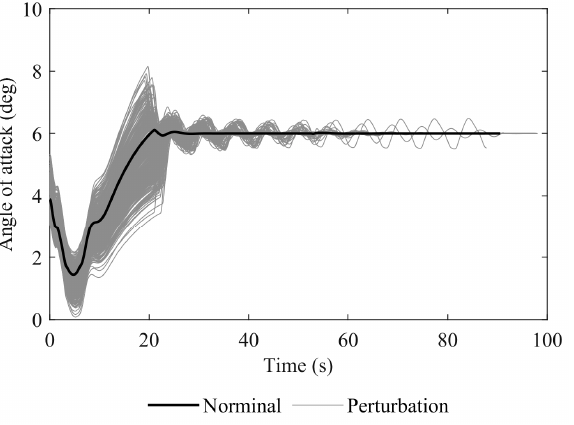
Figure 26. Angle-of-attack response of successful landing without the flight boundary protection.